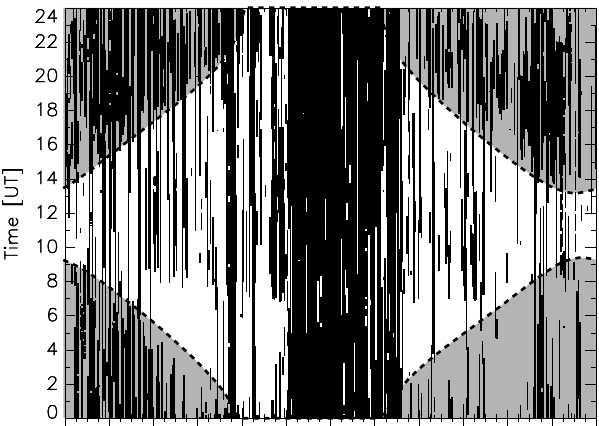
Fig. 1. Distribution of the combined data set from 1997–2005 as a function of time of day and season. The dashed line marks civil twi- light (solar elevation angle − 5 ◦ ). Night-time conditions are shaded. Measurements are indicated by black